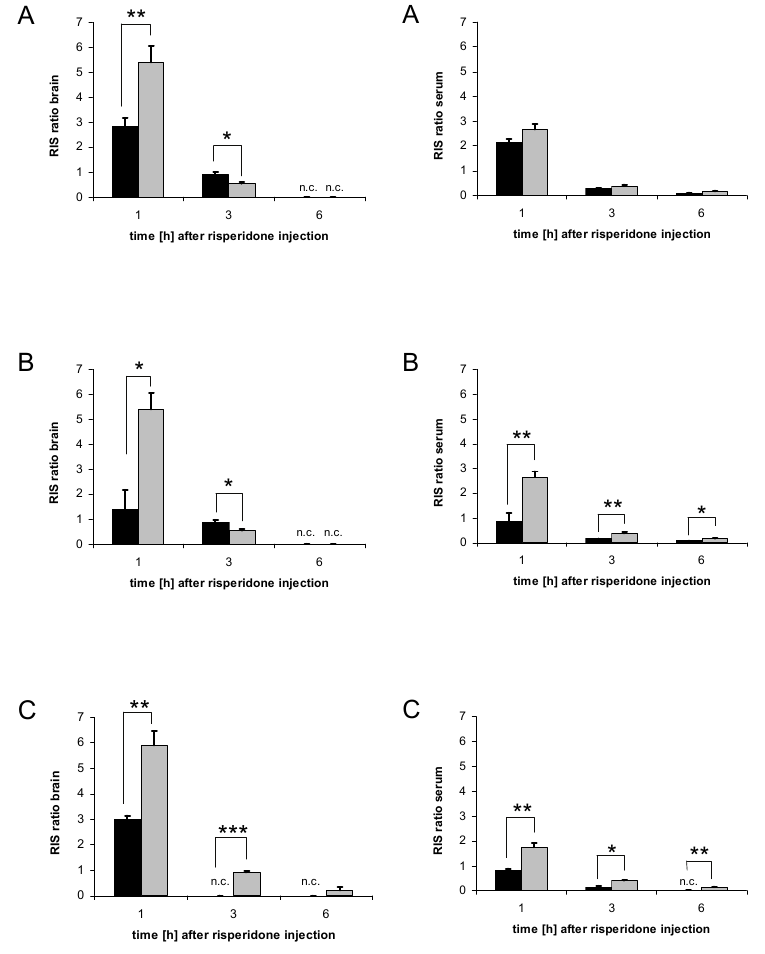
Figure 6. Risperidone/9-hydroxyrisperidone ratio (RIS ratio). RIS ratio of brain (left side) and serum (right side) of mice pre-treated with 10 mg/kg/d rifampicin (A), 50 mg/kg/d dexamethasone (B) or 25 mg/kg/d PCN (C) for 4 days vs. controls. Data presented are mean + /- S.E.M. (* p < 0.05; ** p < 0.01; *** p < 0.001). n.c. = data not calculable due to division by zero, and set to zero for statistical